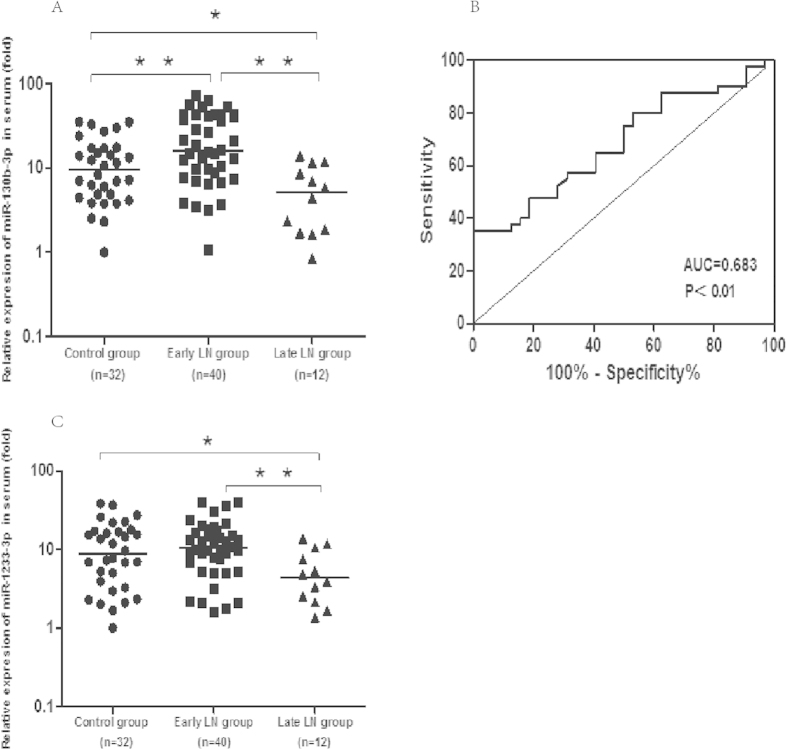
Expression of miR-130b-3p and miR-1233-3p in validation group.(A) Serum miR-130b-3p indifferent stage of LN patients. (B) Receiver operating characteristic (ROC) curves with corresponding area under the ROC curve (AUC) for miR-130b-3p in discriminating LN patients with early stage CKD (stage1–3) from healthy control. (C) Serum miR-1233-3p indifferent stage of LN patients. The line indicates the median value per group. Fold regulation is expressed as RQ based on 2−∆∆Ct *P < 0.05 **P < 0.01